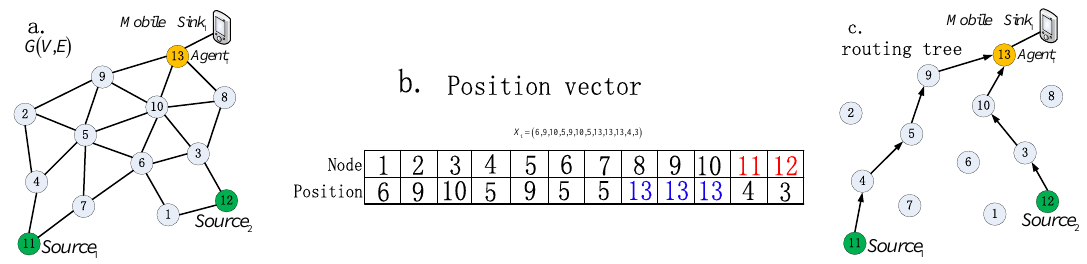
Figure 4. ( a ) Network topology; ( b ) Position vector encoded for ( a ); ( c ) Routing tree decoded from ( b